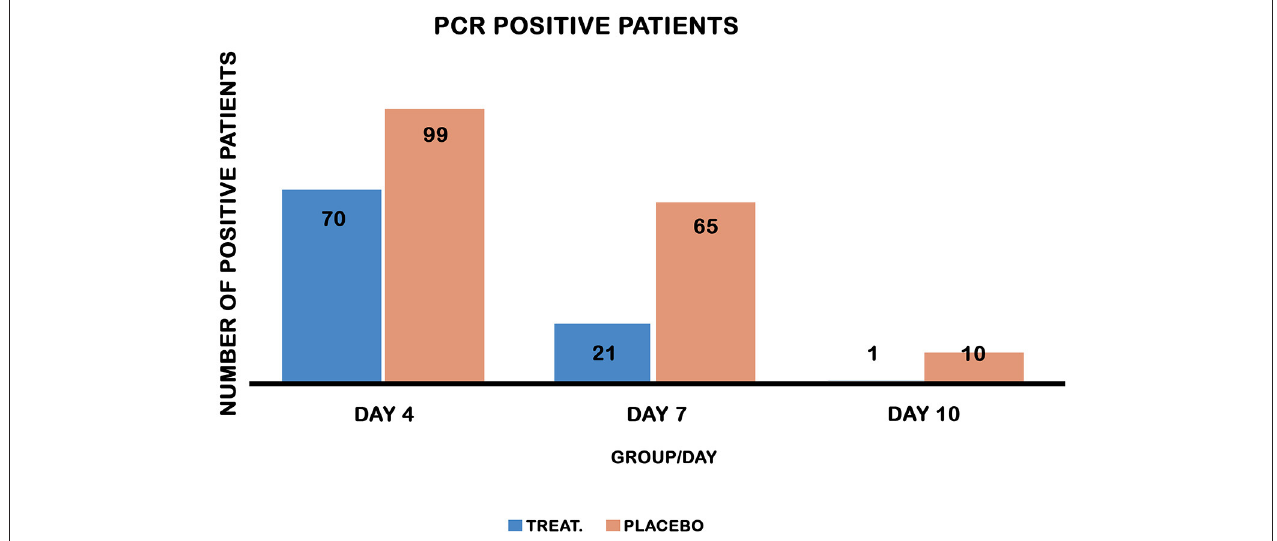
FIGURE 3 | PCR-positive patients on days 4, 7, and 10 in both groups. Chi-square test comparing the recovery of PCR in both treatment and placebo control groups. Treatment reduced PCR-positive patients on days 4, 7, and 10 post-treatment, P values [ < 0.0001, 0.001, and 0.005] respectively.